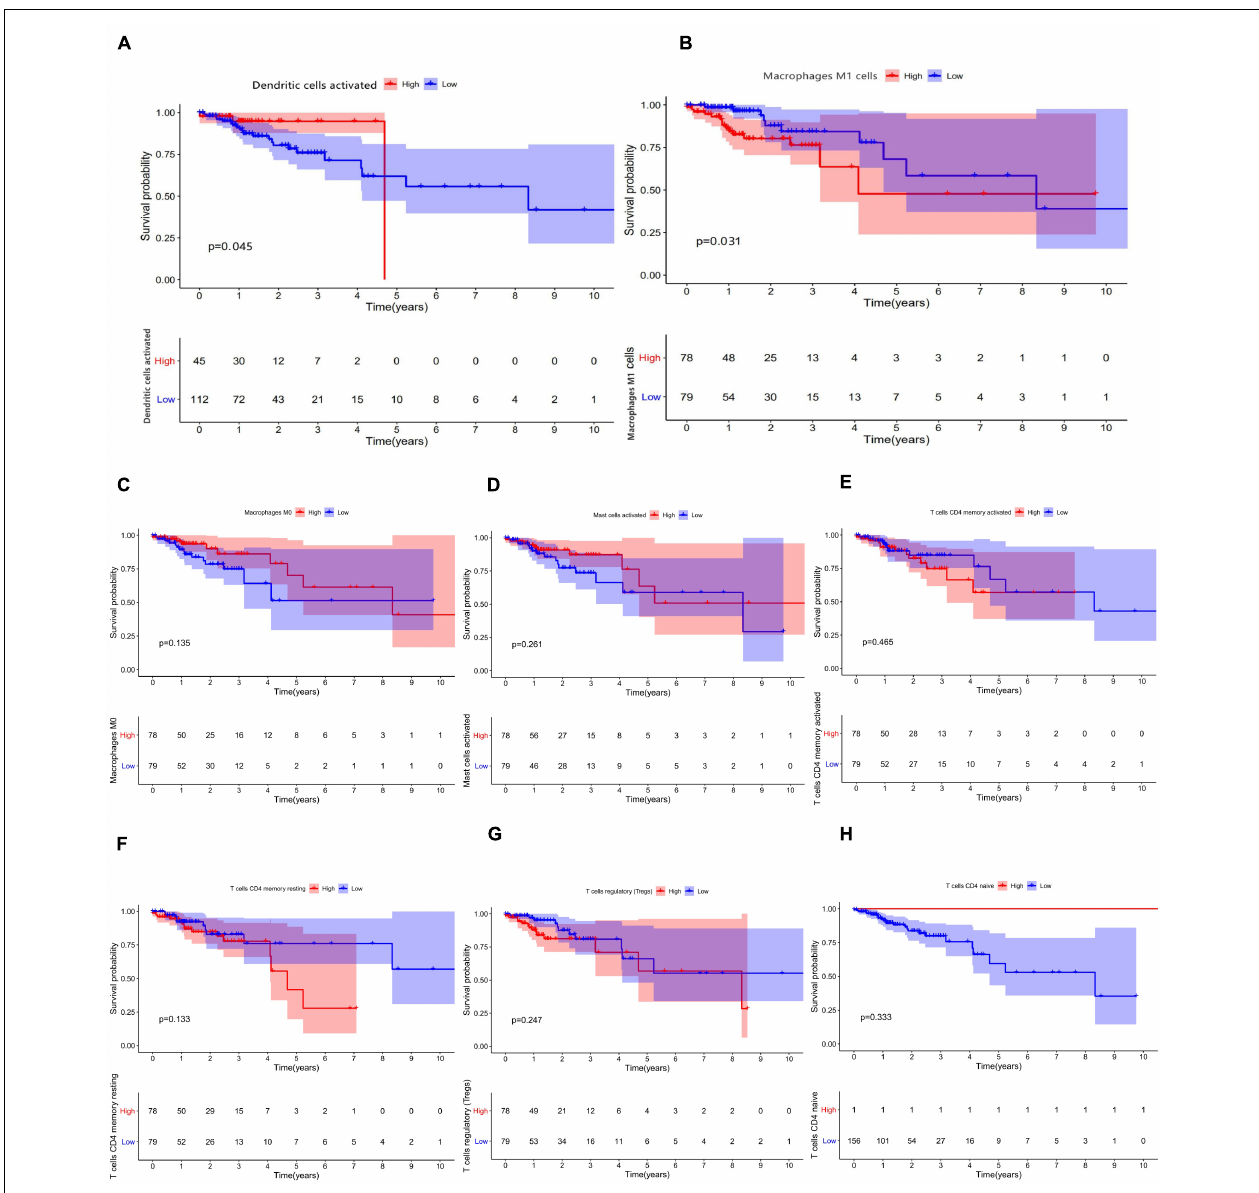
FIGURE 6 | (A–H) Results of prognostic difference analysis of patients with high and low expression of immune